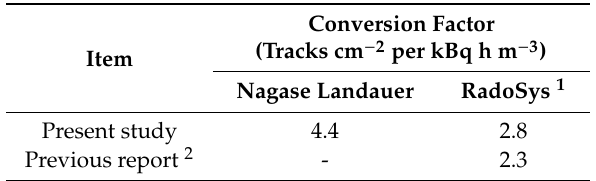
Table 4. The conversion factors of RADUET evaluated by two types of CR-39s in the present study and in a previous study. RADUETs, which contain both CR-39s, were simultaneously exposed to radon atmosphere for evaluation of the di ff erence in